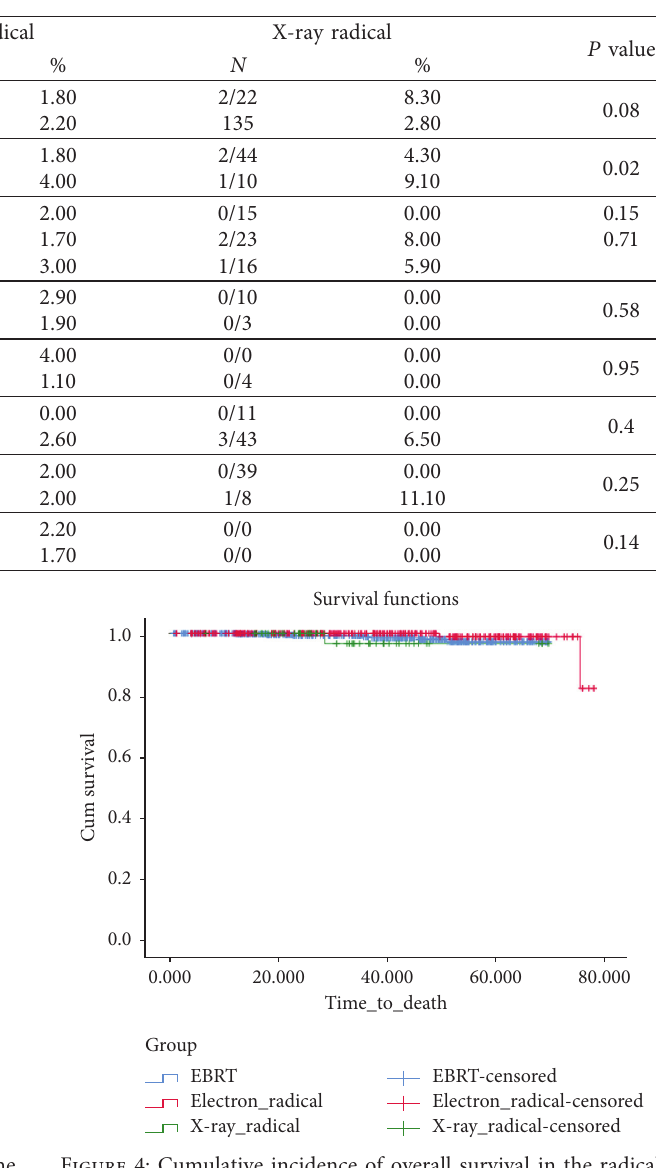
Table 5: Factors associated with recurrence in patients that received radical dose by IORT ( P value was considered concerning each variable that has the most risk).